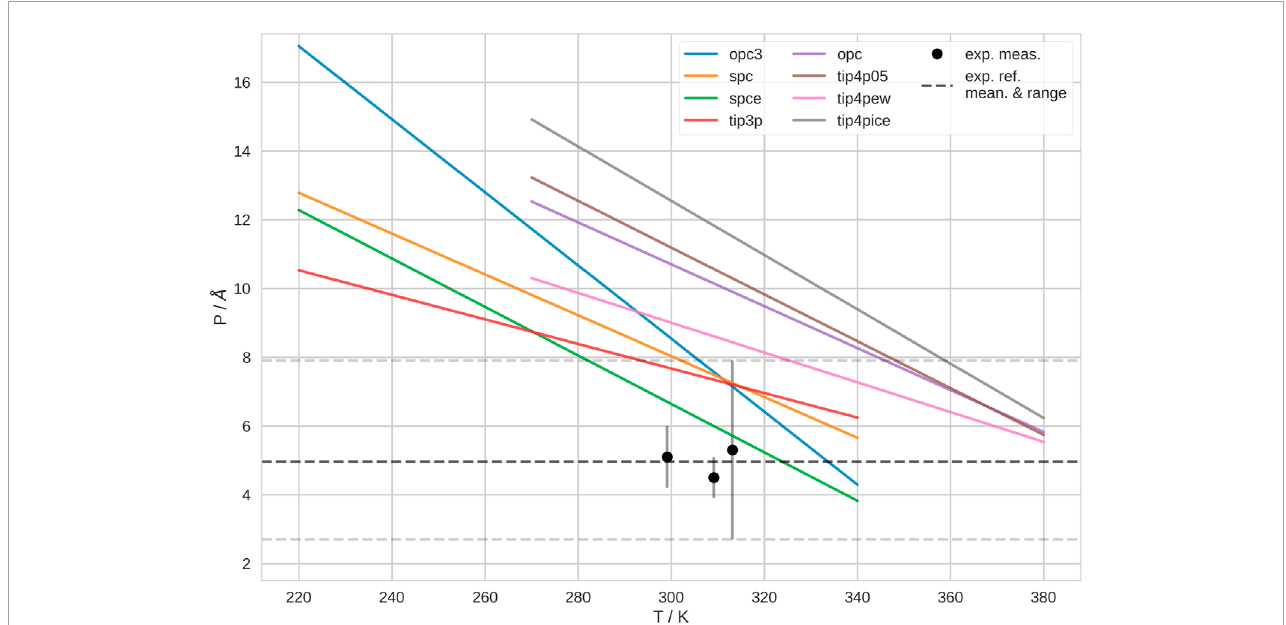
FIGURE 2 Persistence length, P , of PNIPAM at different temperatures, T , in different water models. 3-point water models are listed in the left column of the legend; 4-point water model are listed in the middle column of the legend. Here, we show the fitting lines, of linear fits of P in dependence on T . The raw data with the underlying fits is shown in Supplementary Figure S12 . We show the experimentally determined persistence lengths of PNIPAM as black points (Kutnyanszky et al., 2012). As dashed lines, we show average and range of the experimental measurements as guide to the